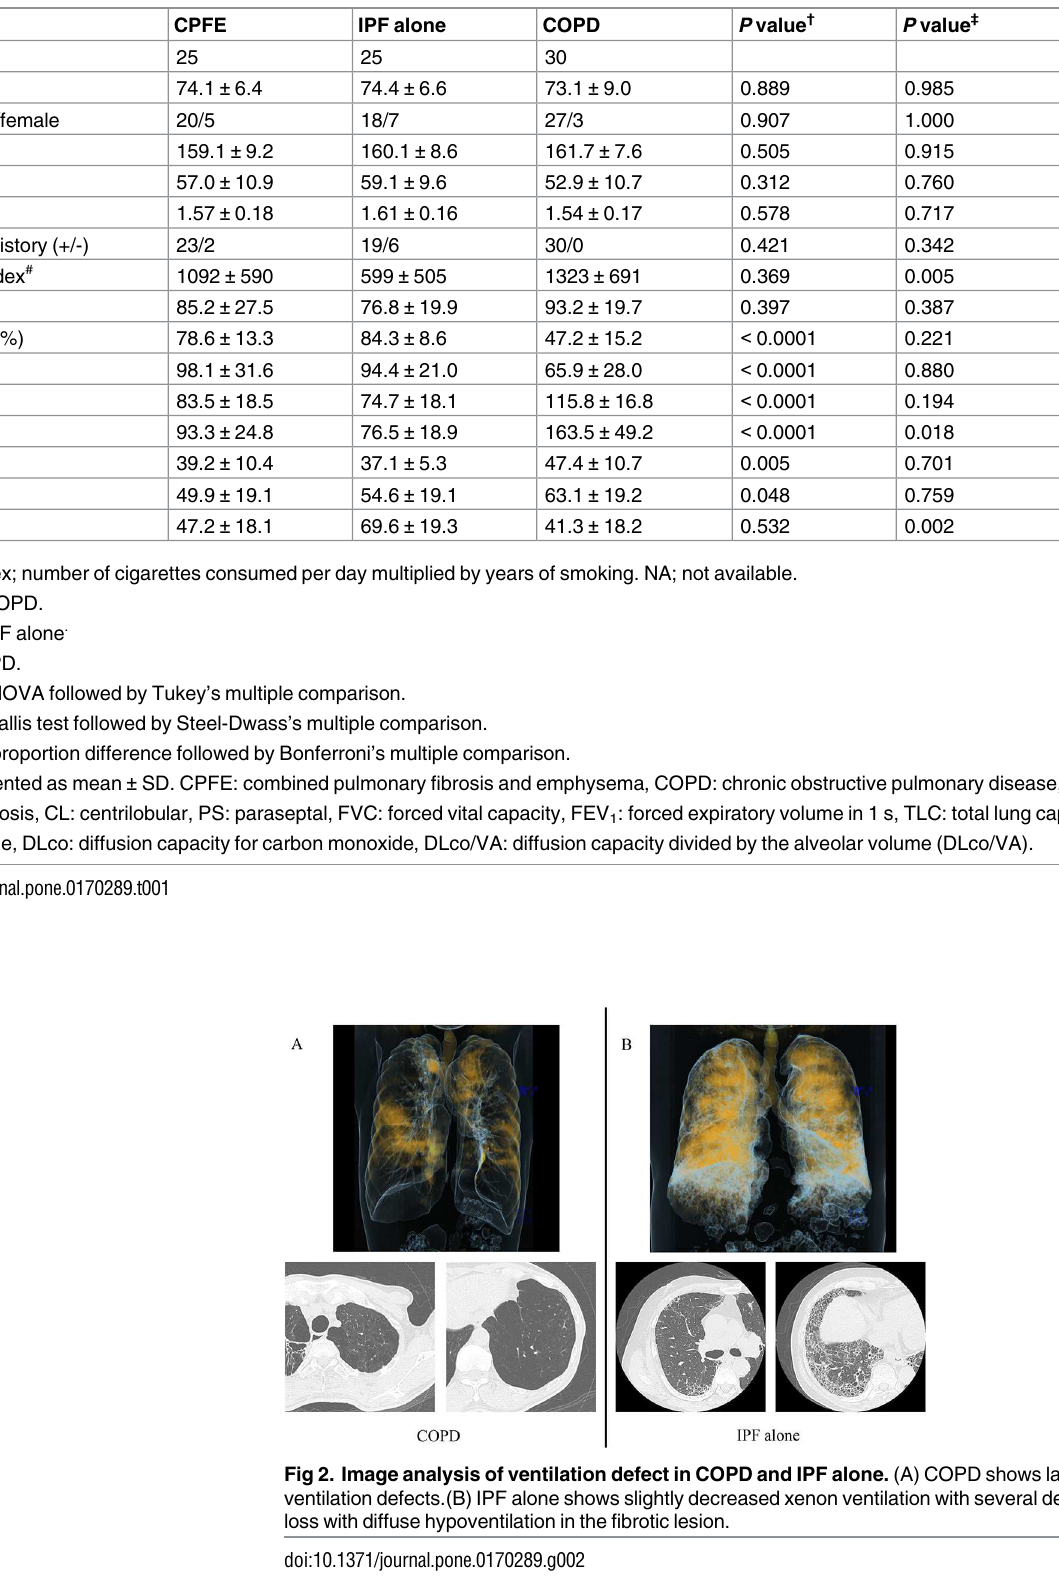
Table 1. Baseline clinical characteristics of the study population.